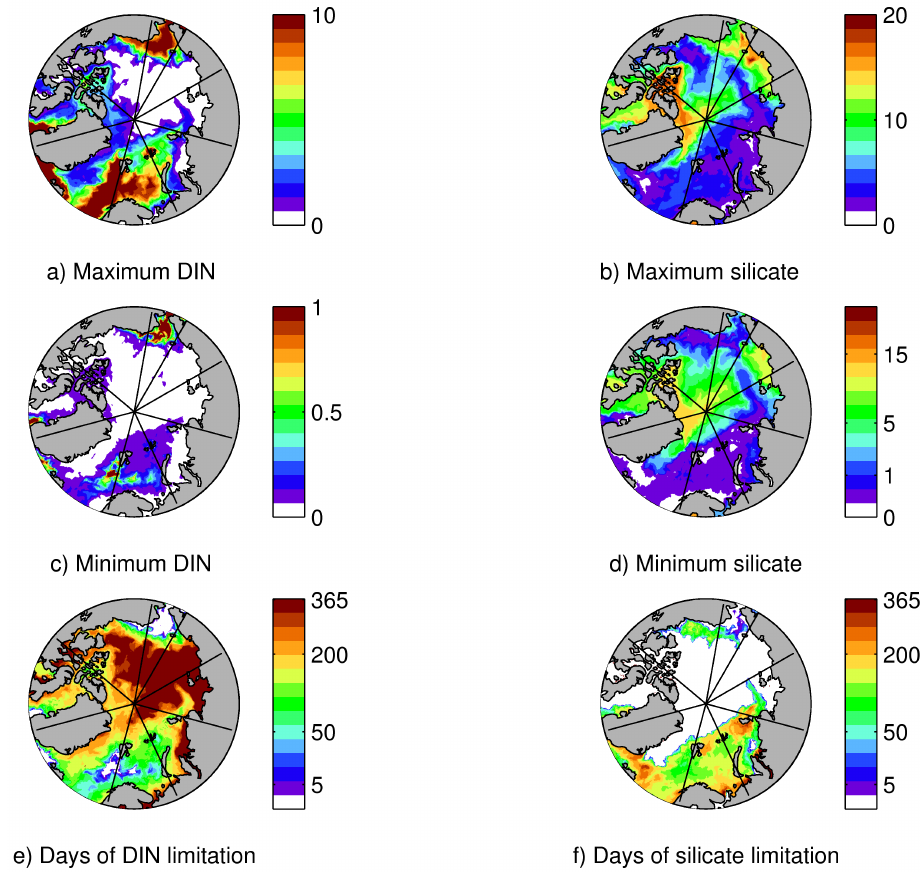
Fig. 5. Model results for year 1997: maximum DIN (a) and silicate (b) concentrations (mmolm − 3 ); minimum concentration (mmolm − 3 ) of DIN (c) and silicate (d) ; number of days that DIN (e) and silicate (f) concentrations are below their half-saturation level (0.5mmolm − 3 for nitrate and 1mmolm − 3 for silicate). Note non-linear